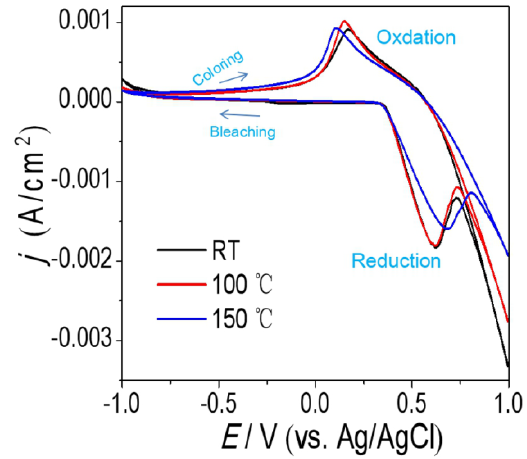
Figure 6. CVs of the NiO x films annealed at RT, 100 °C and 150 °C in 1 M KOH electrolyte. The NiO x films are spin-coated three times and the volume ratio in NiO x inks is IPA:DI water = 1:3.